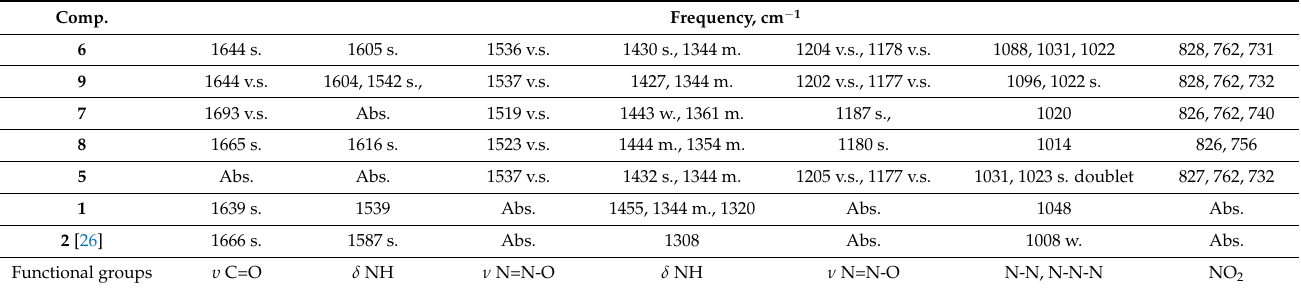
Table 1. IR frequencies of 1 , 2 , 6 – 8 , and 9 .